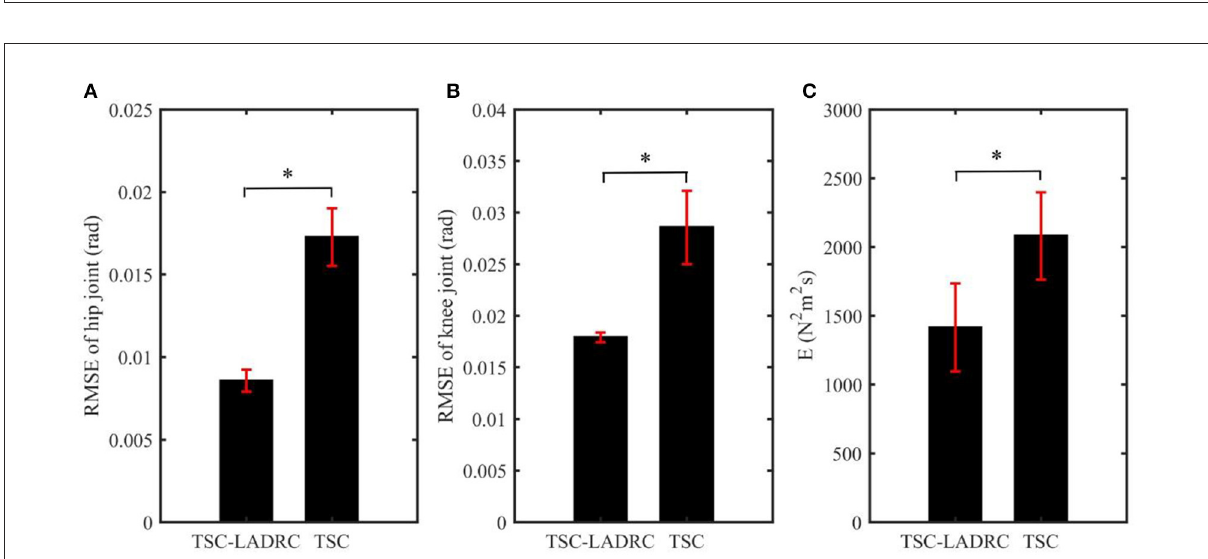
FIGURE7 The mean values of each evaluation index in all experiments: (A) RMSE results of hip joint; (B) RMSE results of knee joint; (C) Energy index. The error bars indicate the standard errors. The asterisk reveals significant difference (p < 0.05).